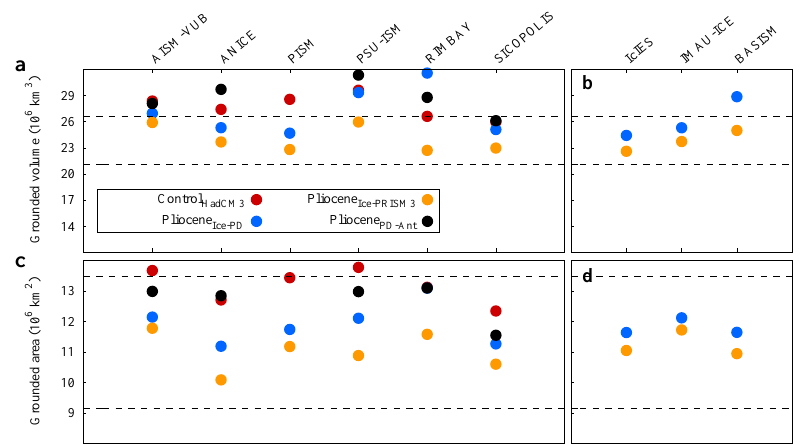
Figure 7. (a) Final grounded ice volume (10 6 km 3 ) for the SIA–SSA models and (b) for the SIA models with Bedmap1. Final grounded ice area (10 6 km 2 ) for the SIA–SSA models and (d) for the SIA models. Control HadCm3 in red, Pliocene Ice-PD in blue, Pliocene Ice-PRISM3 in orange and Pliocene PD-Ant in black. The horizontal dashed lines indicate the PD and Pliocene grounded ice volume and area of the initial ice-sheet topographies.